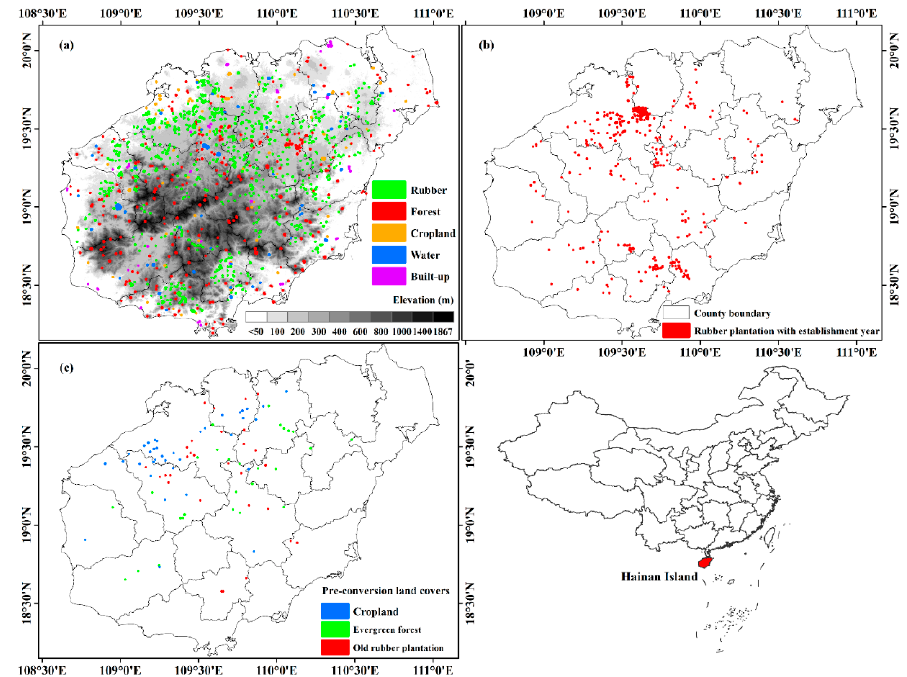
Figure 1. Location and topography of Hainan Island overlaid with ground reference data which was used for generating maps and accuracy assessments for maps of ( a ) rubber plantation in 2015; ( b ) establishment year; and ( c ) pre-conversion land covers.